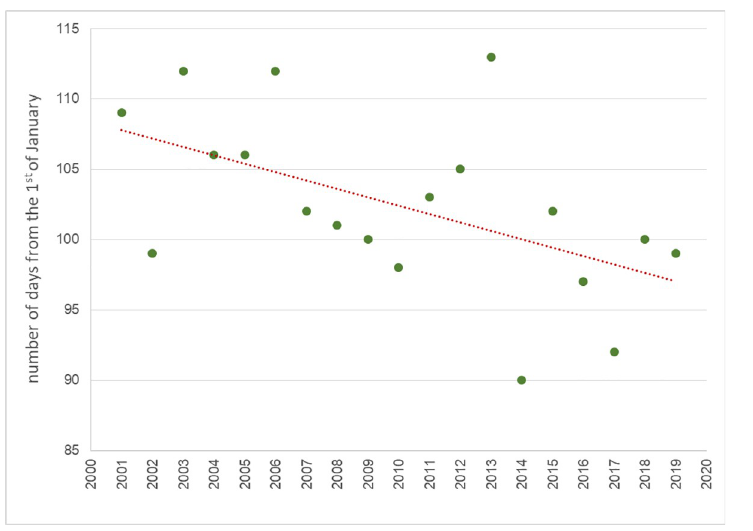
Fig 2. The start of the Betula pollen season in Lublin in 2001–2019.